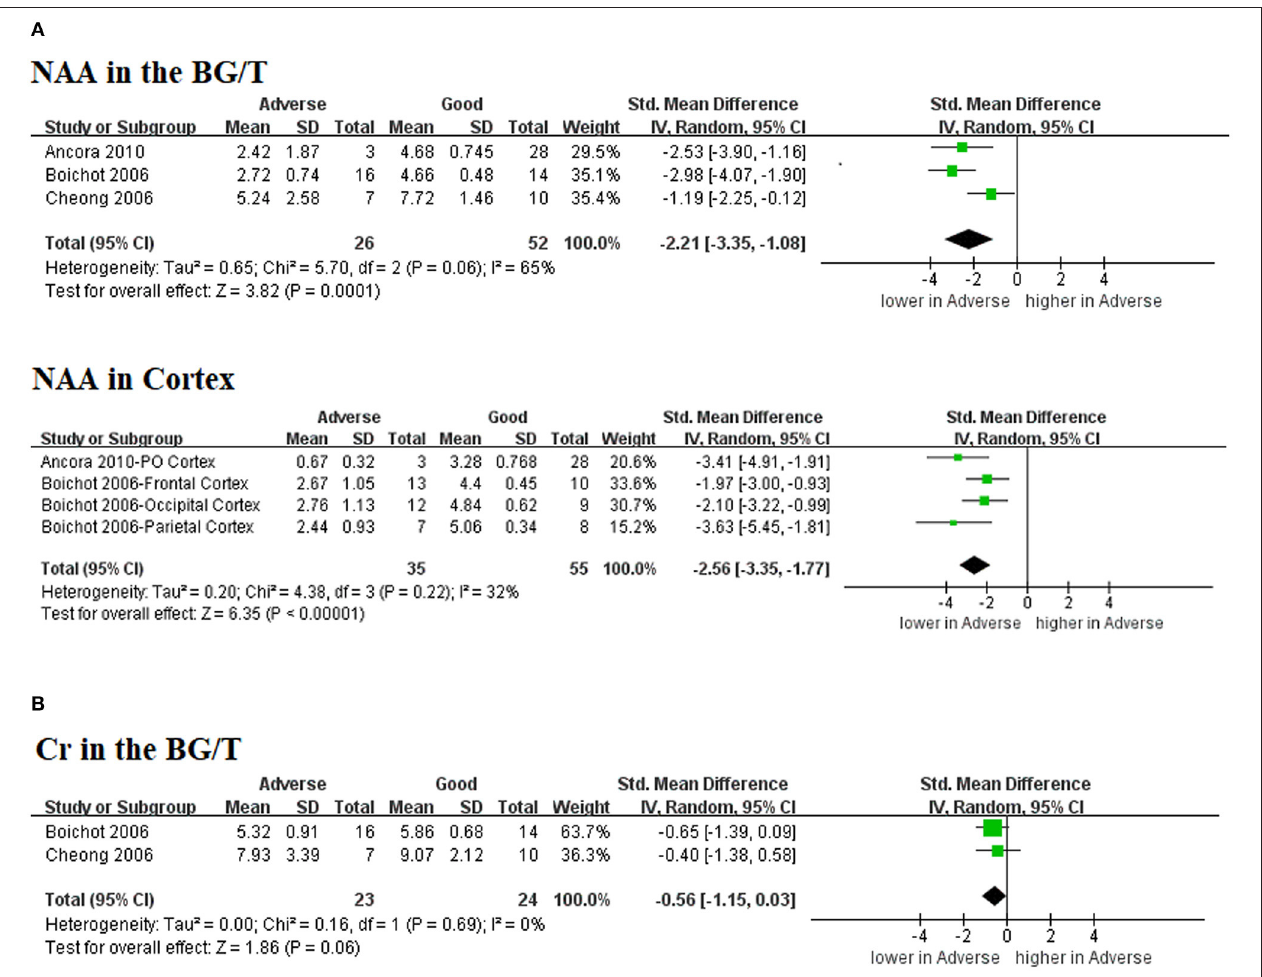
FIGURE 5 | Graphic depiction of the results of meta-analyses: absolute concentration of (A) NAA in the BG/T and cerebral cortex, together with (B) Cr in the BG/T. BG/T, basal ganglia or thalamus; Cr, creatine; NAA,